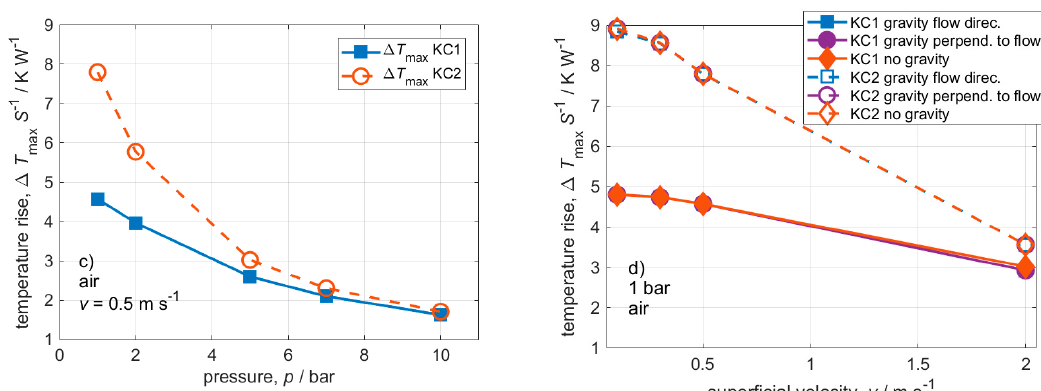
Figure 3. Solid temperature rises per applied heat source intensity for fluid property variation ( a ) Increase in inlet velocity incl. turbulence modelling; ( b ) Influence of fluid type; ( c ) Influence of pressure; ( d ) Influence of gravitational acceleration. Conditions: S = 12.5 W; λ s = 5 W m − 1 K − 1 .